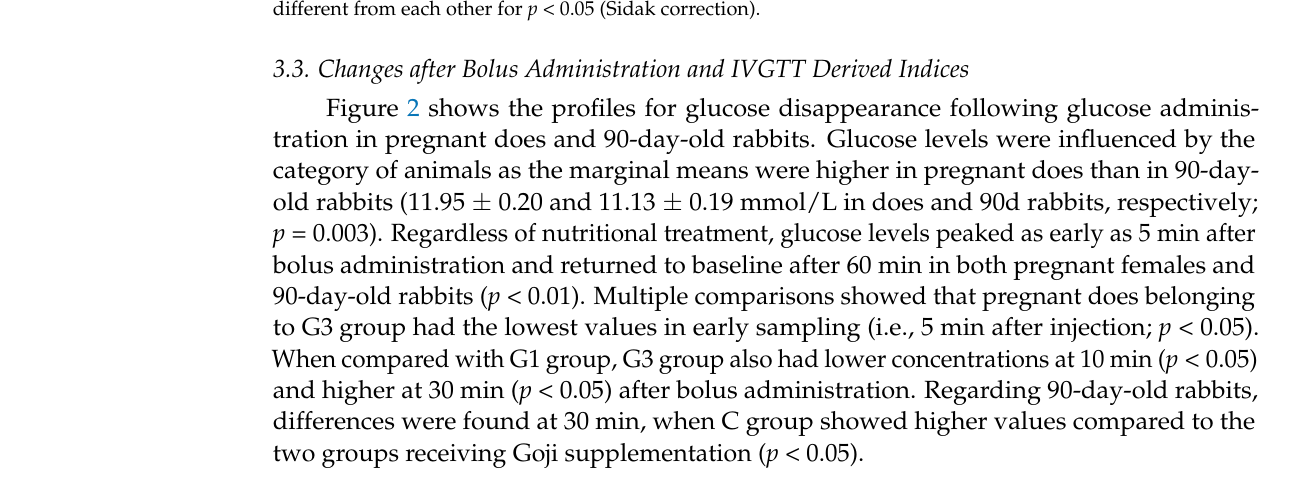
( b ) Figure 2. Changes in blood glucose levels after bolus administration in pregnant does ( a ) and 90- day-old rabbits ( b ) of control group (C, n = 7/category) and groups with 1% (G1, n = 7/category) or 3% (G3, n = 7/category) of Goji berry. * p < 0.05: G3 vs C group. Regarding glucose tolerance test-derived indices (Table 3), several differences be- tween groups were found in pregnant does, which mainly involved the G3 group. Indeed, it showed lower mean values of C max ( p < 0.05) and K el ( p < 0.05) but higher V d ( p < 0.05) than G1 group. The t 1/2 tended to be higher in G3 than C and G1 groups ( p < 0.1). Con- versely, no significant differences were found in the glucose tolerance test-derived indices of 90-day-old rabbits.